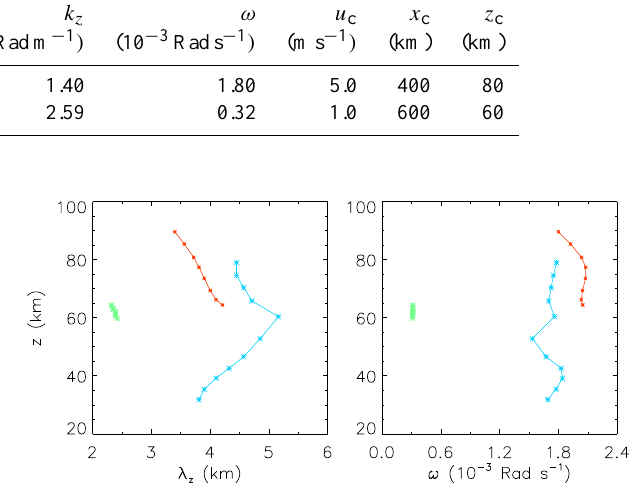
Fig. 4. Variations of (left) absolute vertical wavelengths and (right) wave frequencies with time. The cyan, green and red lines repre- sent waves 1–3, respectively. The asterisks marked at the height of disturbance peak denote the values at each integer hour, and the pa- rameters of wave 3 are presented from t =